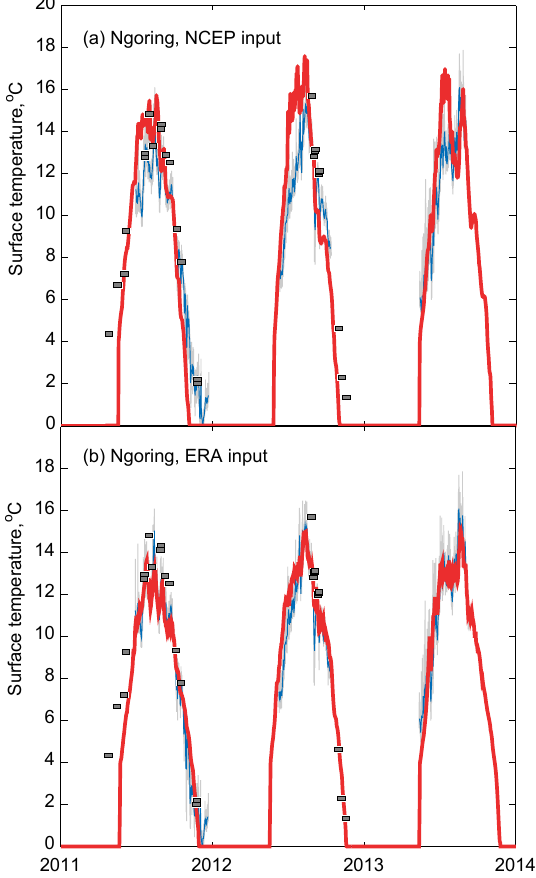
Figure 4. A comparison of the results from the FLake model forced by (a) NCEP/NCAR and (b) ERA-Interim reanalyses against the in situ lake surface temperatures in Ngoring. The thick solid (red) lines are the model predictions; the thin solid (blue) lines are the in situ bulk temperatures at 0.5m depth; the half-tone (gray) lines are the skin surface temperatures determined from the upward long- wave radiation (Li et al., 2016); and the symbols are the available T s estimations from satellite data.